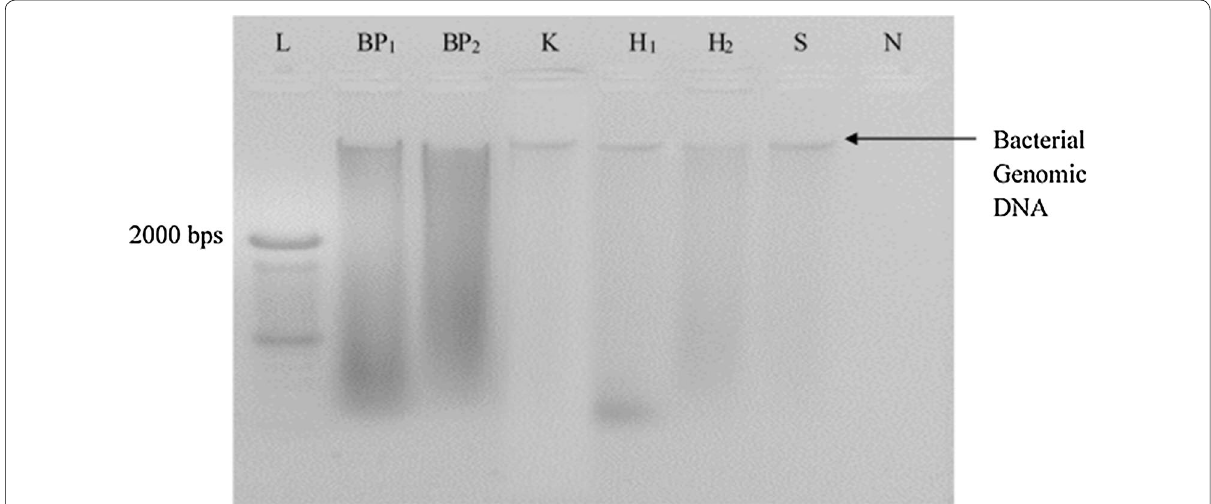
Fig. 1 The quality of DNA extracted from wound tissue debridement specimen No. 1 using six DNA extraction methods